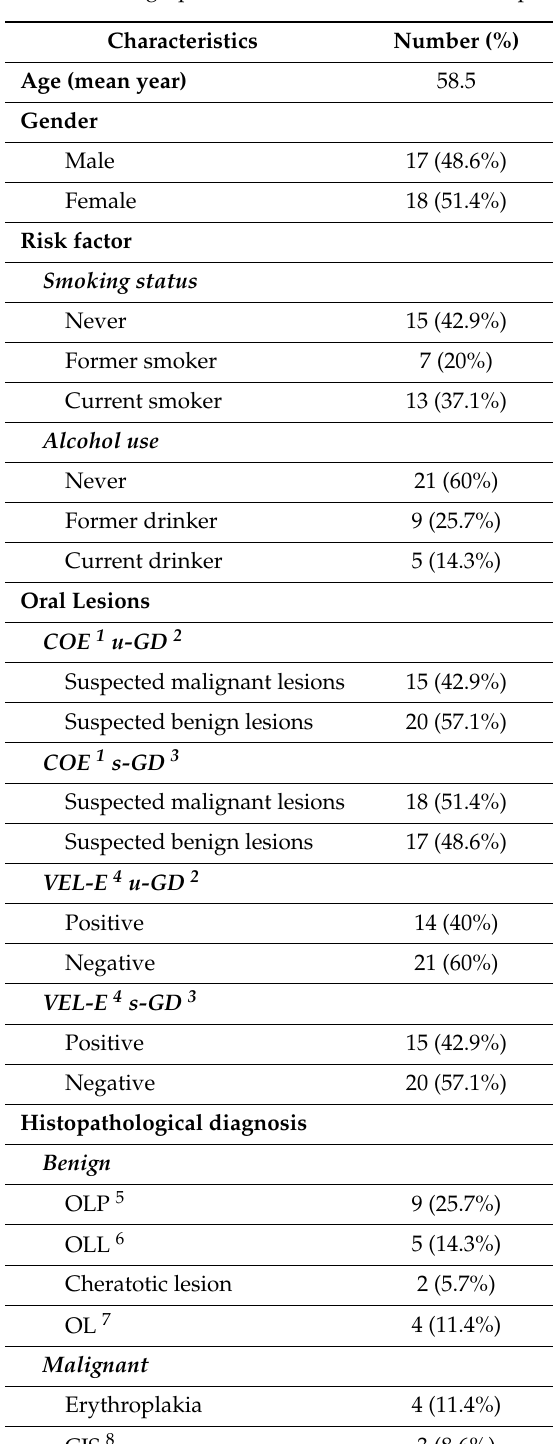
Table 1. Baseline demographic and clinical characteristics of